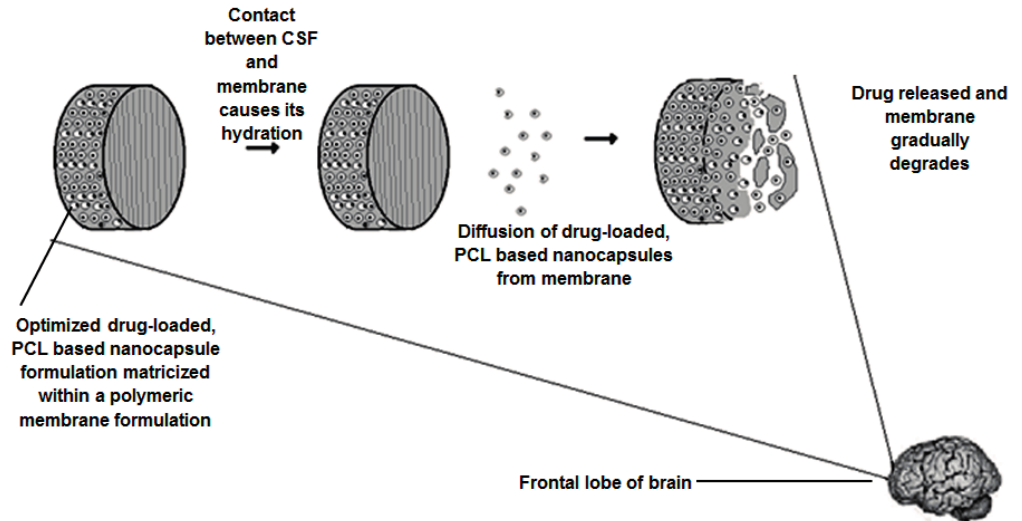
Figure 17. Proposed mechanism of action and site of implantation of the optimized nanocapsules incorporated within a polymeric